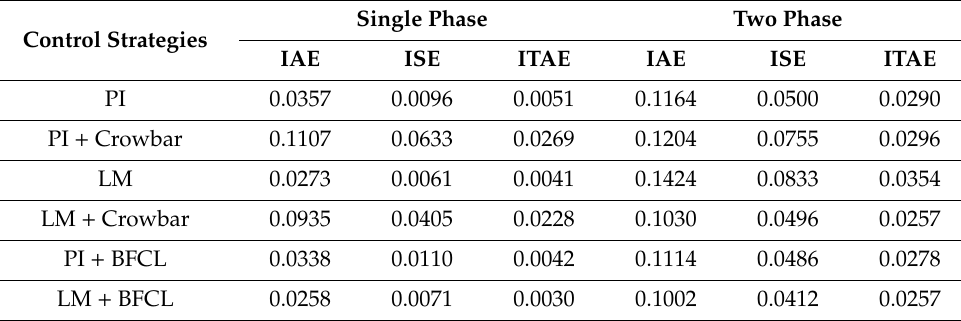
Table 2. Performance index analysis of the Designed Control Scheme for Id.